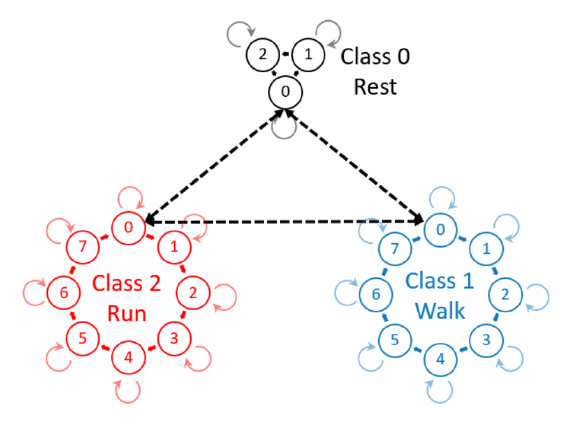
Figure 1. Hierarchical hidden Markov model (hHMM) consisting of three classes each of, respectively, 3, 8 and 8 internal states. The internal states are strictly circular with the possibility of recursion. The dashed arrows represent the transition model between individual HMMs that represent classes such as rest, walking and